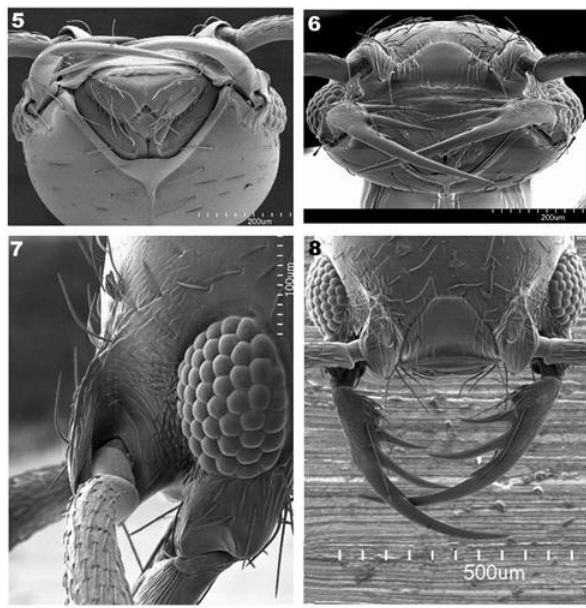
R. Keller. Fig. 9: mesosoma, left lateral view. Fig. 10: petiole, left lateral view. Fig. 11: gaster, left lateral view. Fig. 12: gaster (partial) with detail of pygidium and hypopygium, left lateral